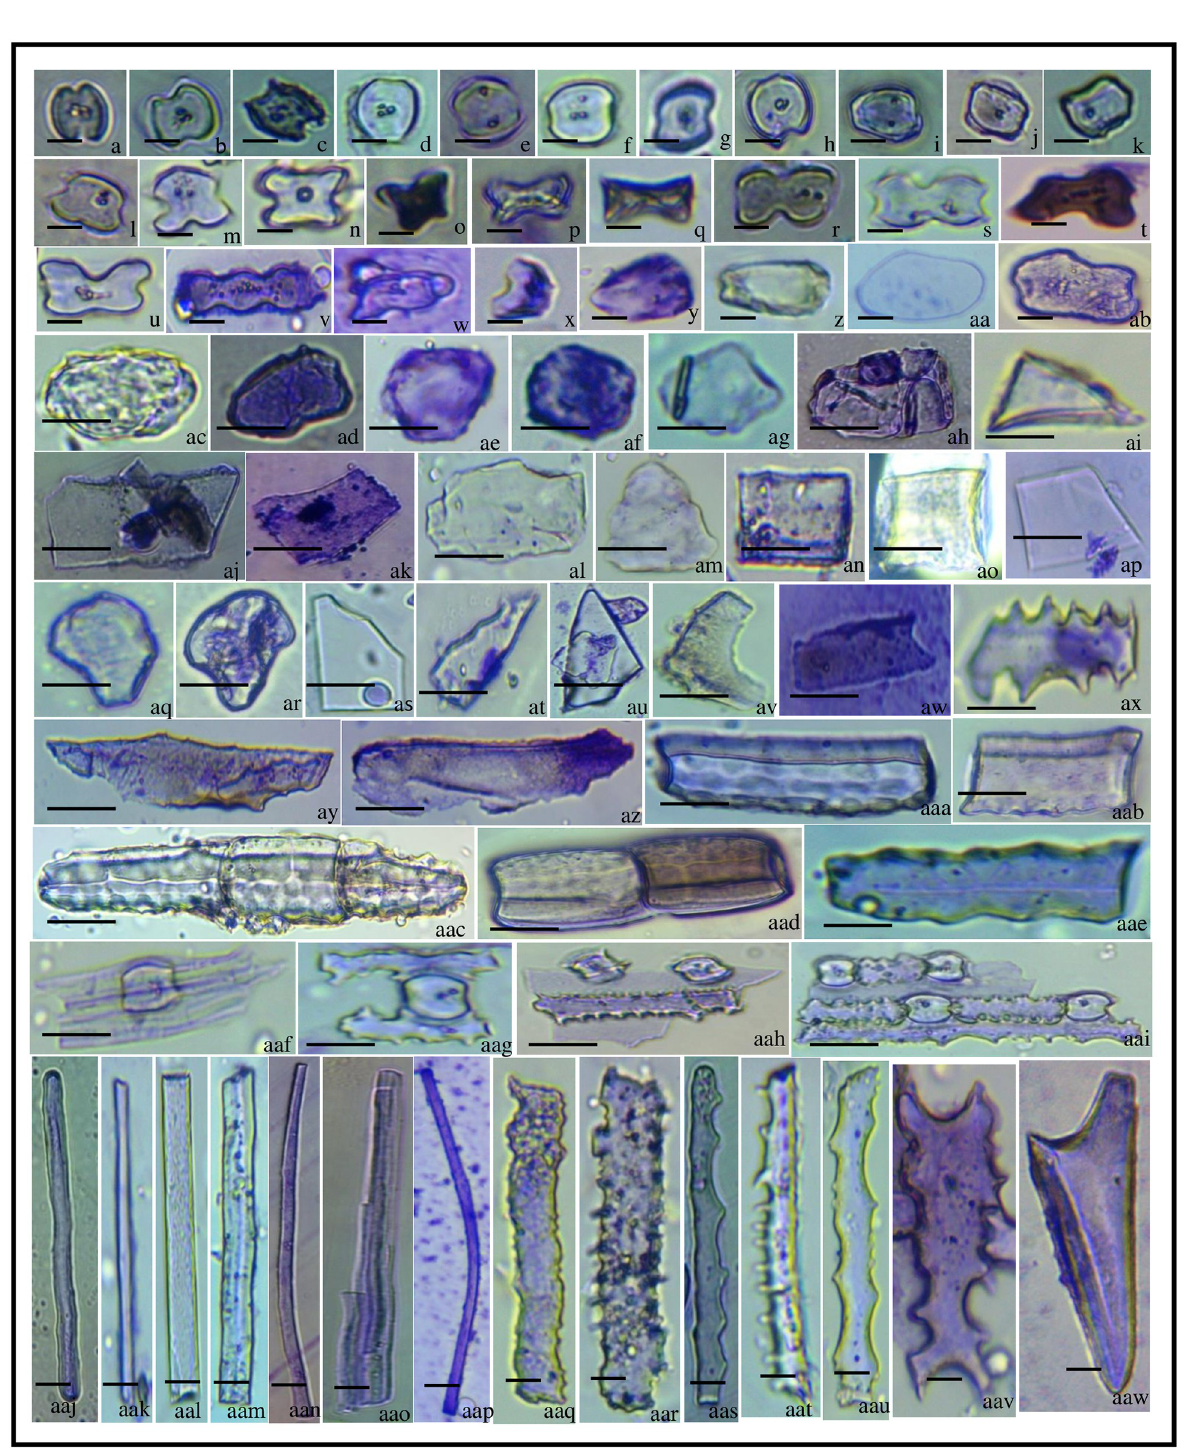
Fig 5. Phytolith morphotypes of Acrachne racemosa (Heyne ex Roem. & Schult.) Ohwi (Leaves). Saddle (a-k); Saddle with notch (l, m); Cross (n, o); Flat tower (p, q); Bilobate (r-u); Polylobate (v); Silica cork cells (w); Reniform (x); Ovate (y); Oblong (z); Ellipsoidal (aa-ad); Globular granulate (ae, af); Globular polyhedral (ag); Blocky polyhedral (ah); Triangular (ai); Polyhedral (aj); Tabular simple (ak, al); Tabular polyhedral (am); Parallelepipedal cell (an); Cuboid (ao); Trapezoids (ap); Cuneiform bulliform (aq, ar); Scutiform (as-au); Crescent moon (av); Rectangular (aw); Elongate echinate (ax); Scutiform (ay); Elongate irregular (az); Smooth elongate (aaa); cuboid (aab); Blocky (aac, aad); Sinuate elongate (aae); Elongate/Saddle (aaf); Elongate echinate/Saddle (aag-aai); Smooth elongate (aaj-aan); Elongate irregular (aao); Arcuate (aap); Elongate echinate (aaq-aav); Acute Bulbous (aaw). bar = 10 μ m (a-ab, aaj-aaw); 40 μ m (ac-aai).